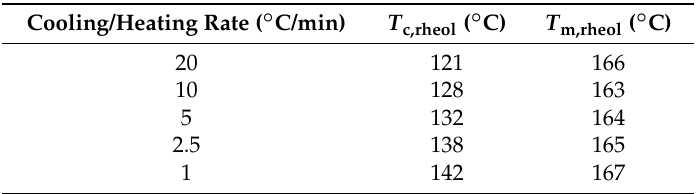
Table 1. The rheological crystallization and melting temperature (for the definition see the text) at different cooling/heating